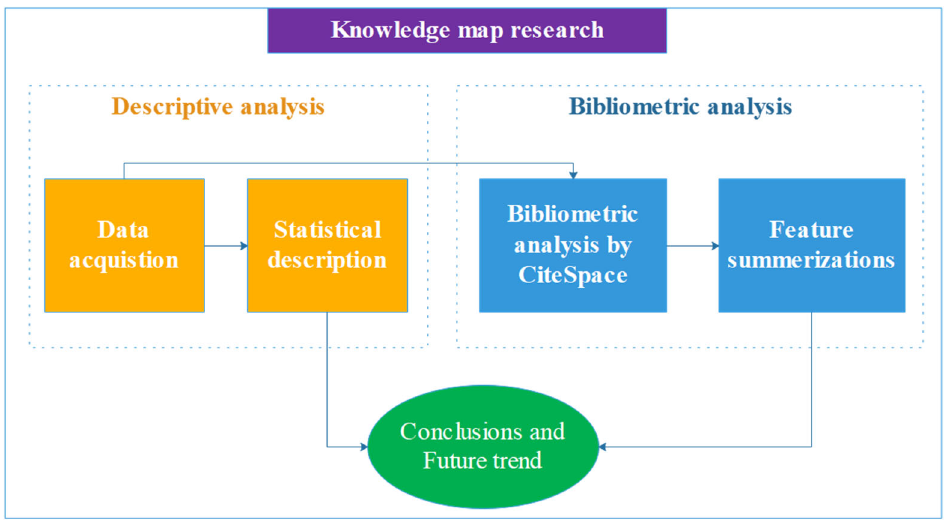
Figure 2. Overall research framework.